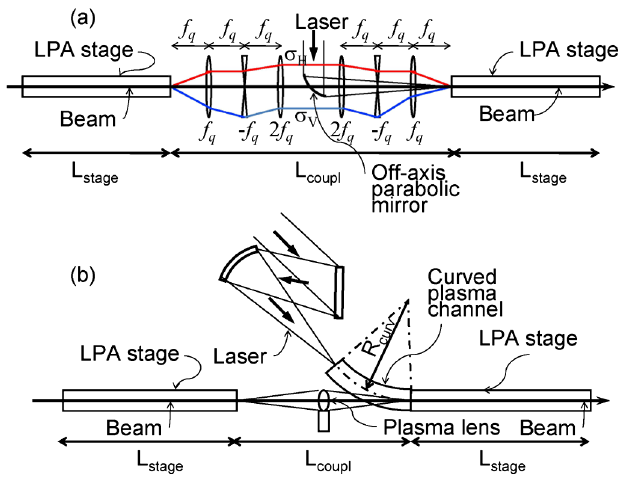
FIG. 5. Schematic illustrations of multistaged laser-plasma ac- celerators composed of the LPA stages and the coupling section made of the conventional technologies (a) and the plasma-based technologies (b). For example, the conventional coupling uses an off-axis parabolic mirror for laser focusing and two triplet lenses for beam focusing, while the plasma-based coupling uses a curved plasma channel for the laser off-axis injection and a plasma lens for the beam injection to the next LPA